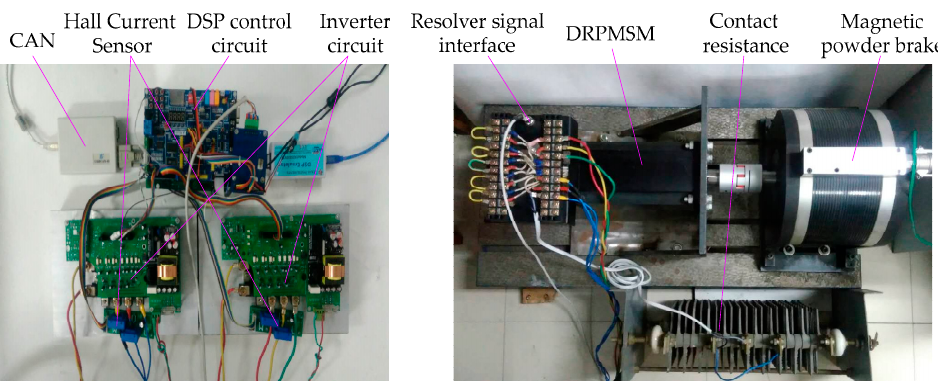
Figure 14. The experimental system.